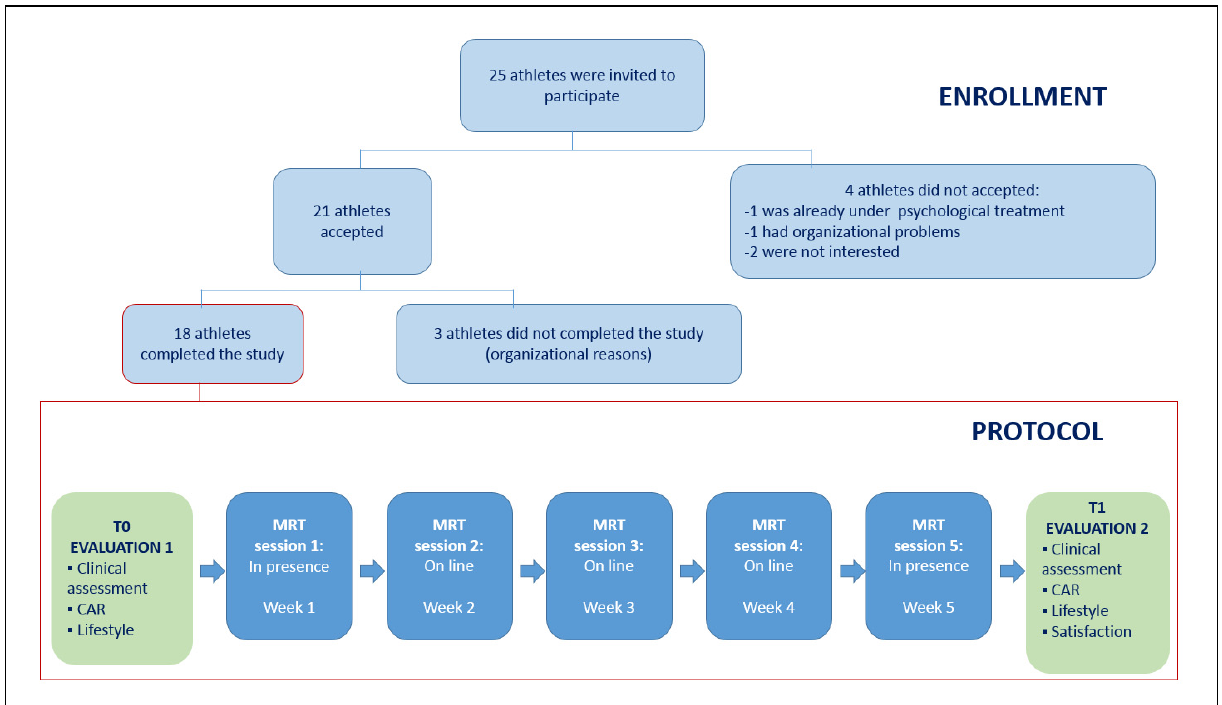
Figure 1. Flow chart of the enrollment procedure and protocol.